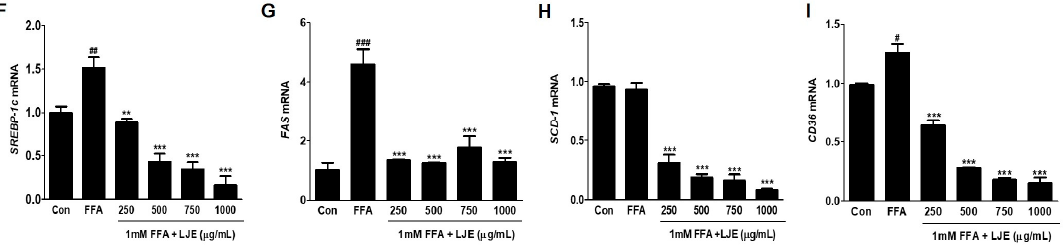
Figure 3. Effects of LJE on lipogenesis markers in HepG2 cells. ( A – E ) Immunoblot analysis; ( F – I ) Quantitative real-time PCR analysis. Data represent means ± SEM. # p < 0.05, ## p < 0.01, ### p < 0.001 vs. Con; ** p < 0.01, *** p < 0.001 vs. FFA.